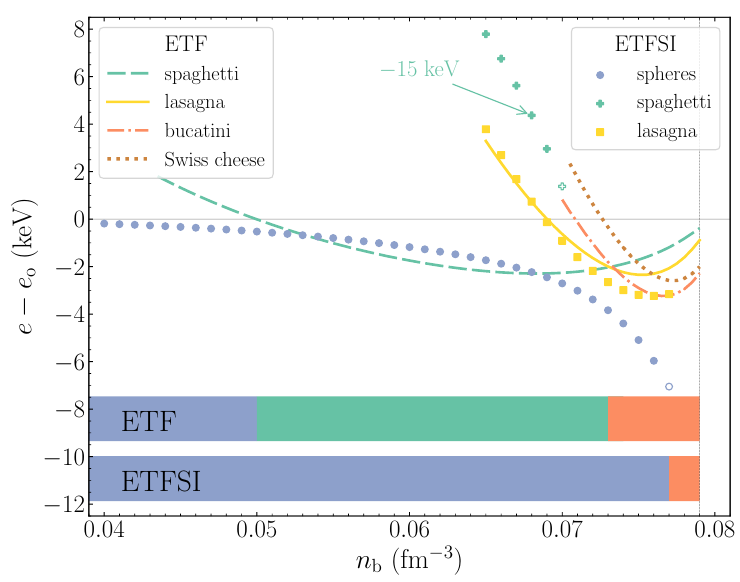
Figure 1. Energy per nucleon for di ff erent pasta phases with ETF energy of spheres subtracted versus baryon number density. Lines correspond to ETF calculations: green dashed for spaghetti, yellow solid for lasagna, orange dash-dotted for bucatini and dotted brown for Swiss cheese. ETFSI results are indicated by symbols: blue circles for spheres, green crosses for spaghetti and yellow squares for lasagna. Note that the ETFSI energies for spaghetti have been shifted by 15keV to make them visible on the plot. Bars in the bottom part represent the di ff erent pasta regions with the same color